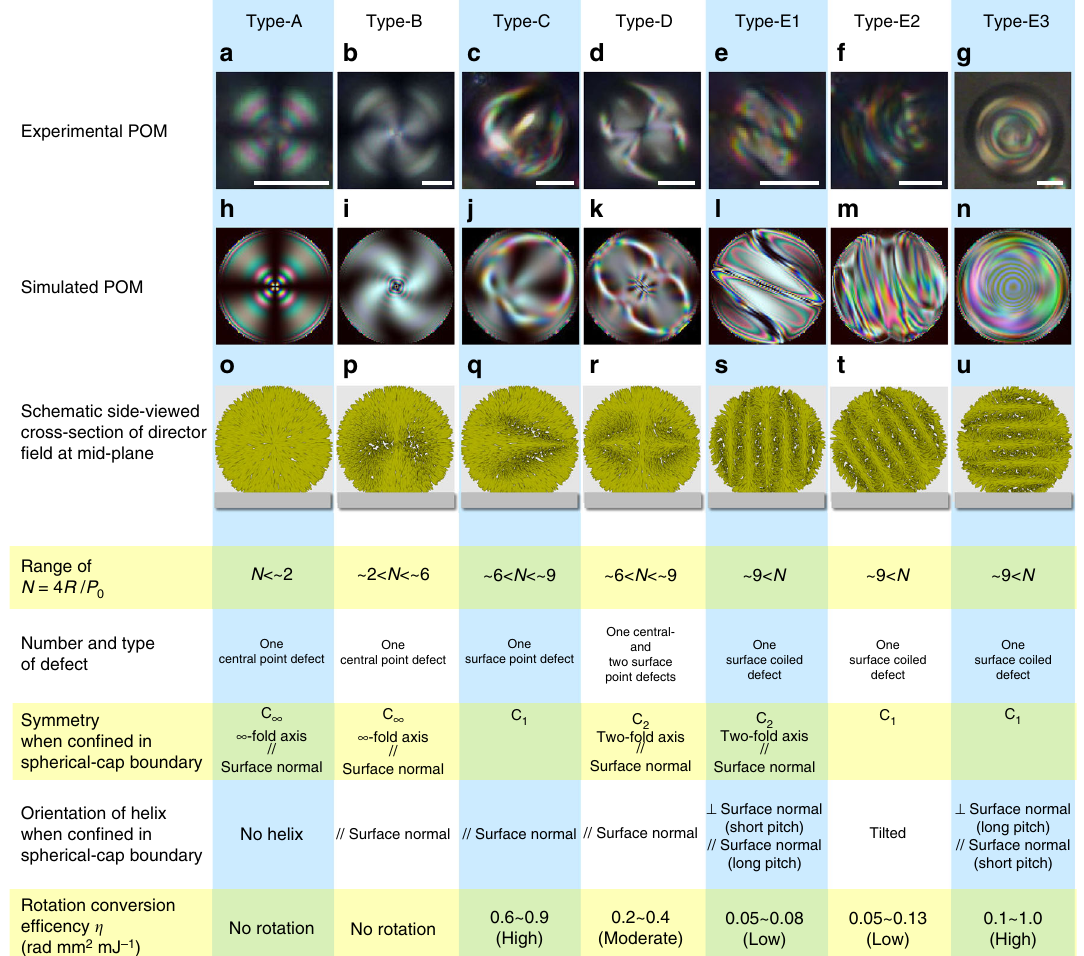
Fig. 1 Summary of experimentally obtained POMs, simulated POMs and topological features of dispersed Ch droplets. a – g Polarising micrographs of fi ve types of Ch droplets dispersed in a fl uorinated oligomer: a Type-A, b Type-B, c Type-C, d Type-D and e – g Type-E droplets. Type-E droplets are further sorted into three sub-types, namely, e Type-E1, f Type-E2 and g Type-E3. Scale bars, 10 μ m. The concentrations of the chiral dopant are 0.2 wt% in a , 0.5 wt% in b , 1.0 wt% in c , d and g , and 2.0 wt% in e and f . h – n Simulated POM images by means of the Jones matrix method, corresponding, respectively, to a – g . The structural formulations for these structures are described in Supplementary Notes 1 – 4 (Supplementary Equations (1) – (8)). h Type-A and i Type-B are calculated based on the director distributions given by Supplementary Equations (1) and (2). j Type-C is calculated with Supplementary Equations (3) and (4) and ( k ) Type-D with Supplementary Equations (5) and (6). l Type-E1, m Type-E2 and n Type-E3 are calculated with Supplementary Equations (7) and (8) with three different helix directions h with respect to the cell normal ( = z -axis//temperature gradient), i.e., l , n and m correspond to h ⊥ z , h//z , and h inclined from the z -axis, respectively, (see Fig. 9c). For these droplet types, the structural properties and physical features of HIR, i.e., the conditions of the factor N , number and topological types of defects, symmetry groups, orientations of the helical axis, and η values, are summarised together. r. ( o - u ) 3D schematics of the calculated director fi elds at the midplane (see also Figs 8 and 9 for other